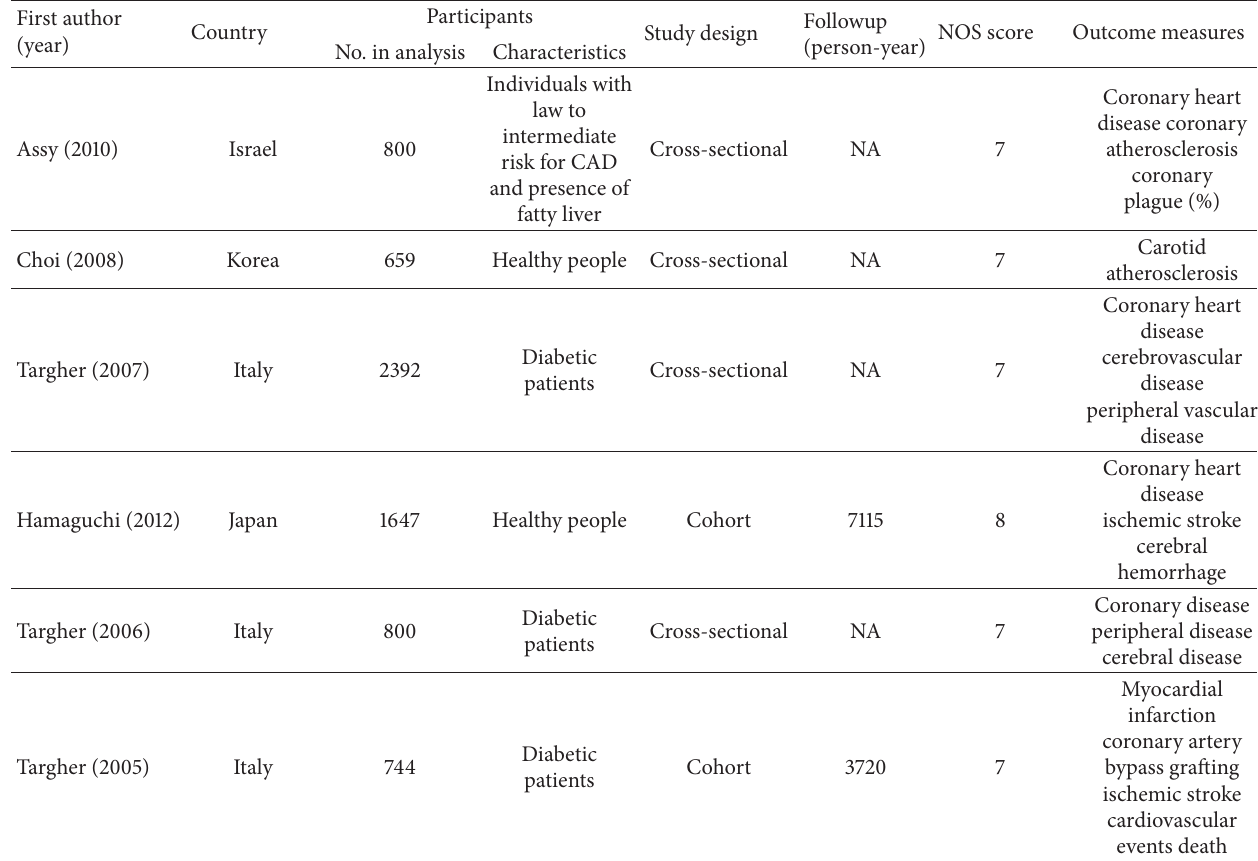
Table 1: Characteristics of studies include in